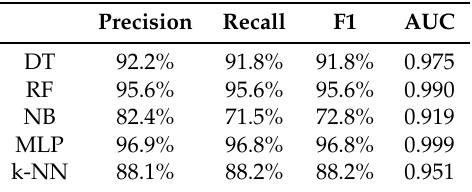
Table 3. Classification performance of different classifiers.